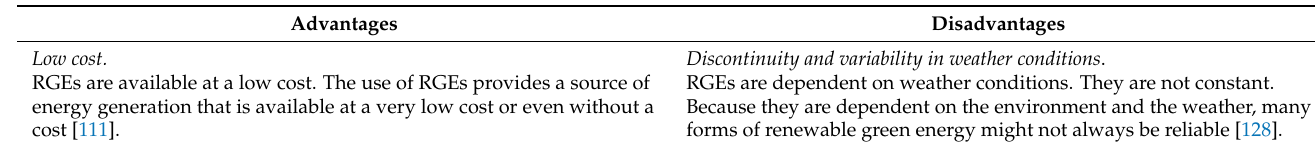
Table 1. Main advantages and disadvantages of renewable green energy sources